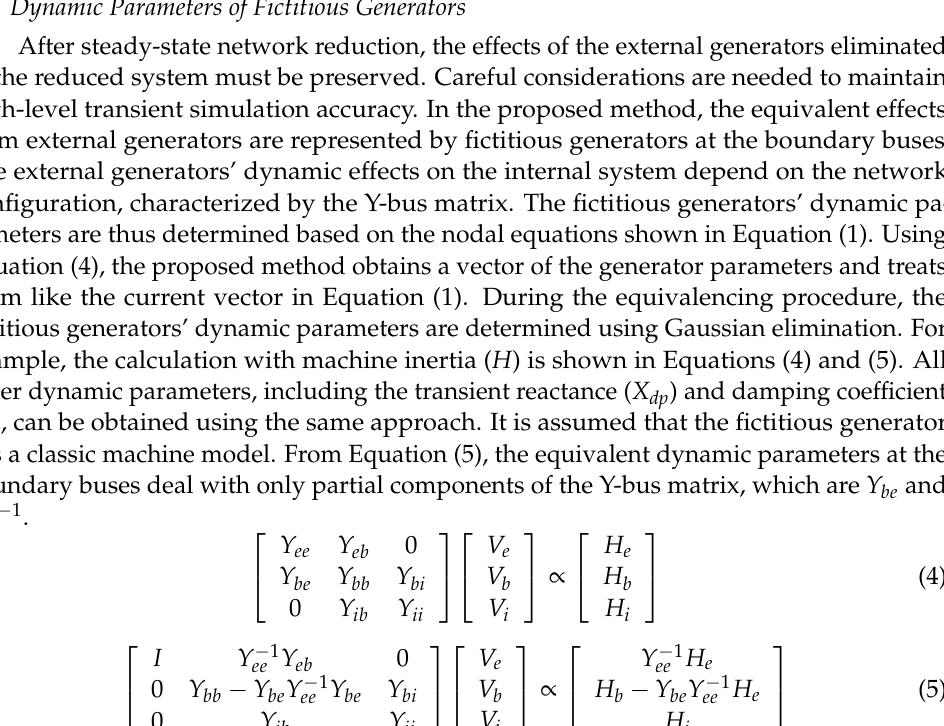
Figure 2. Ward admittance method for steady-state network reduction. ( A ) Original system corre- sponding to (1); ( B ) reduced system corresponding to Equation